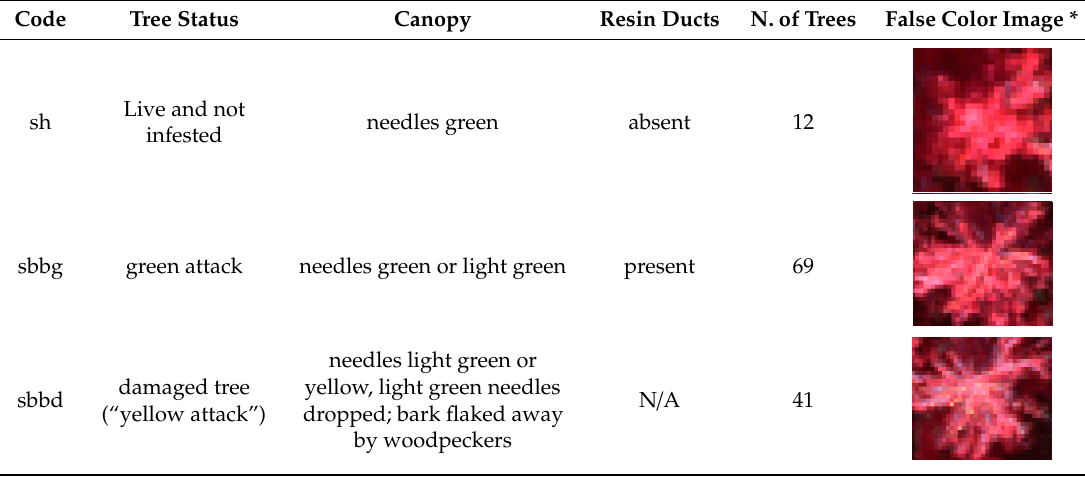
Table 3. The classification of mature spruce trees based on the field investigation. N/A indicates that resin ducts were not used to classify the tree into sbbd class.